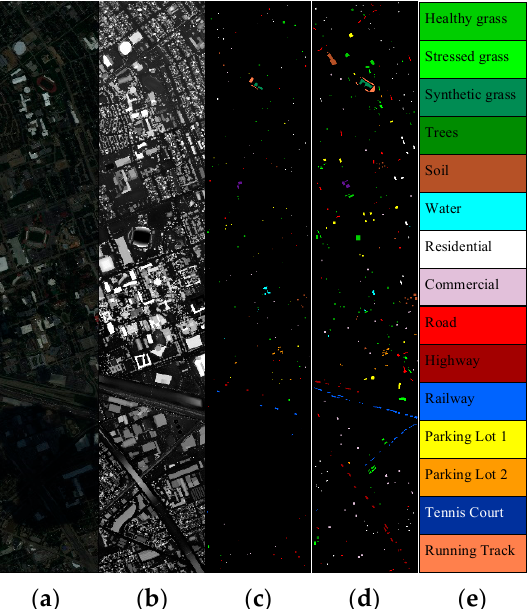
Figure 5. Visualization of Houston dataset: ( a ) false-color image (using 64, 43 and 22 bands as R, G and B, respectively); ( b ) LiDAR image; ( c ) training samples; ( d ) test samples; ( e ) color code. Table 1. List of the number of training and test samples for each class in Trento datasets. Table 2. List of the number of training and test samples for each class in Houston